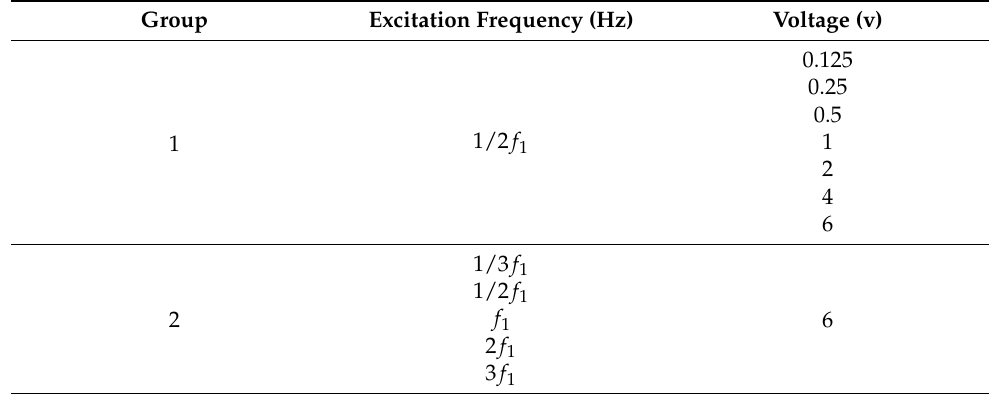
Table 3. Harmonic excitation parameters.